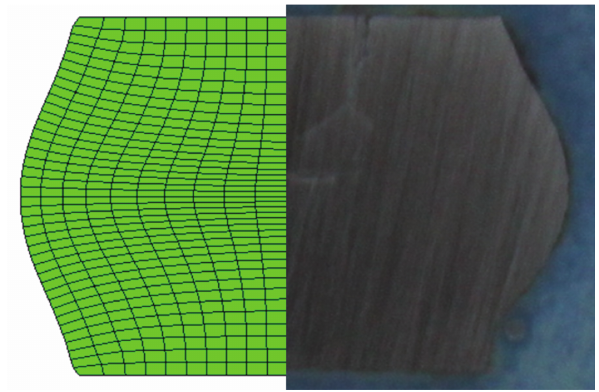
Figure 12: Comparison of the section shape between the experiment and the